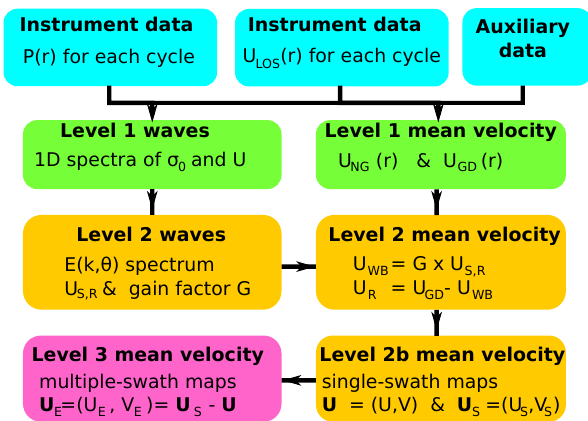
Figure 5. Logical tree going from Level 0 raw data to Level 3 grid- ded fields of surface velocity and wave parameters. For gridding with multiple satellite passes, we propose using the quasi-Eulerian surface velocity defined as U E = U − U S (Jenkins,